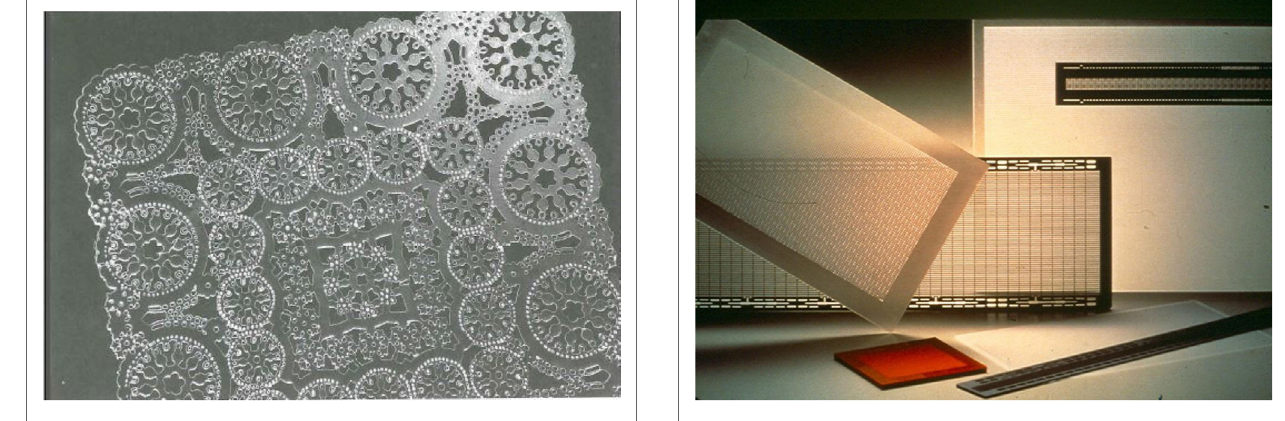
FiGURe 5 | Fotoform ® and Fotoceram ® (bottom) products . FiGURe 4 | Fotoform ® glass lace